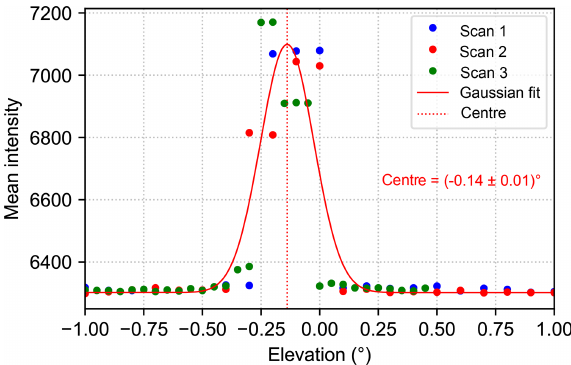
Figure 7. Measured intensities for the three individual scans (coloured dots) and the fitted Gaussian (red solid line) obtained from the near-lamp measurements by the IUP-HD instrument in the UV spectral